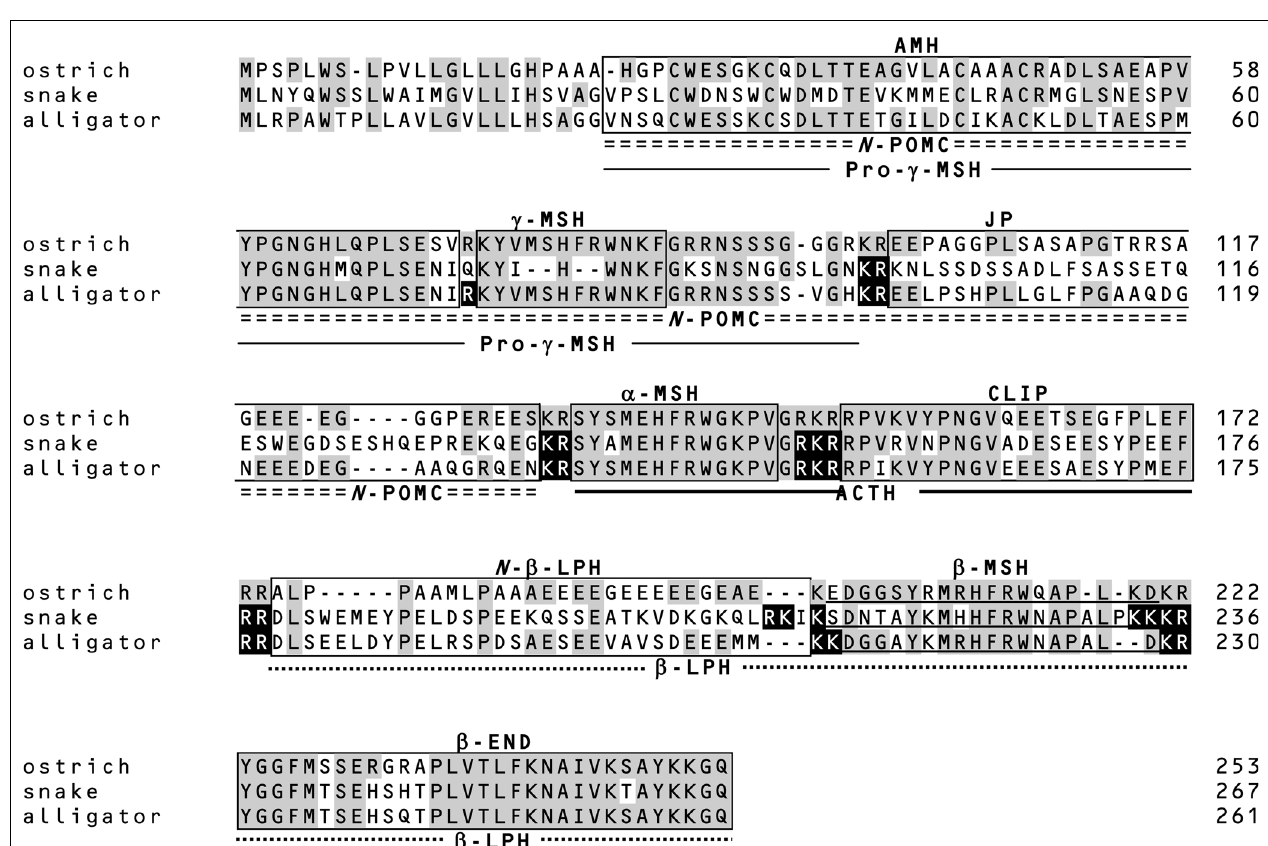
snake and alligator POMCs determined based on the peptides identified by mass spectrometry and peptide analysis (11, 12). Positions of the amino acid are indicated on the right